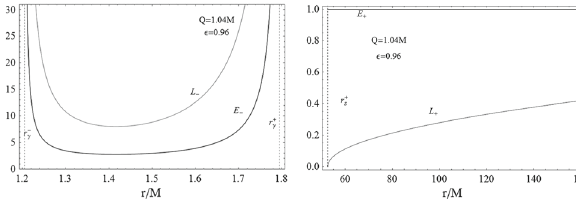
√ √ Fig. 16 Class : 5 /( 2 6 ) M < Q < ( 3 6 / 7 ) M and (cid:9)(cid:9) (cid:2) + ≤ (cid:2) < M / Q . Parameter choice is as follows: Q = 1 . 04 M and (cid:2) = 0 . 96. Then (cid:9)(cid:9) (cid:2) + = 0 . 811927, M / Q = 0 . 961538 r + s = 52 . 4944 M , r − γ = 1 . 20538 M , and r + γ = 1 . 79462 M .Circularorbitsexistwithangularmomentum L = L + ( gray curve ) and energy E = E + ( black curve ) in r − γ < r < r + γ ( left plot ) and L = L − in r > r + s ; L = 0 at r = r + s ( right plot )